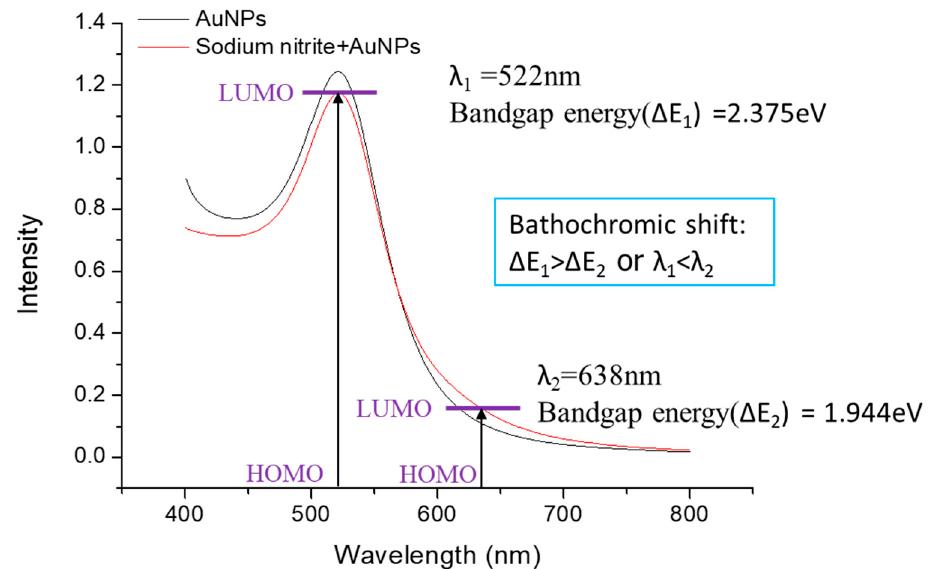
Figure 5. Probable mechanism for the bathochromic shift of NaNO 2 + AuNPs.